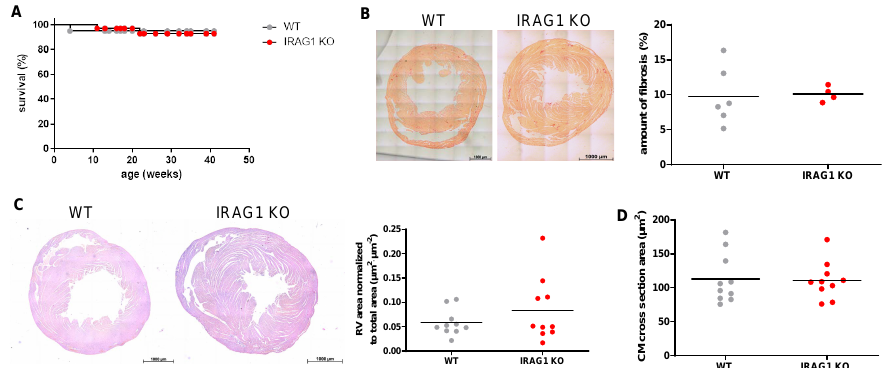
Figure 4. Disruption of IRAG1 gene in mice showed no obvious sign of mortality, increment in right ventricular (RV) fibrosis and area, and cardiomyocytes area. ( A ) Kaplan–Meier analysis was performed to analyze the di ff erence of survival between the two groups. ( B ) Sirius red staining was performed to analyze fibrosis in mice heart and further quantified. Bars indicate 1000 µ m. ( C , D ) H & E staining was Fig 4 performed with mice heart to analyze RV ( C ) and cardiomyocytes area ( D ) and further quantified. Bars indicate 1000 µ m. Number of animals used: ( A ) 20 WT and 35 IRAG1 KO, ( B ) 6 WT and 4 IRAG1 KO, ( C ) 10 WT and 10 IRAG1 KO, ( D ) 10 WT and 10 IRAG1 KO. All quantified data were represented as individual point and bar indicated the mean, two-tailed unpaired t -Test.